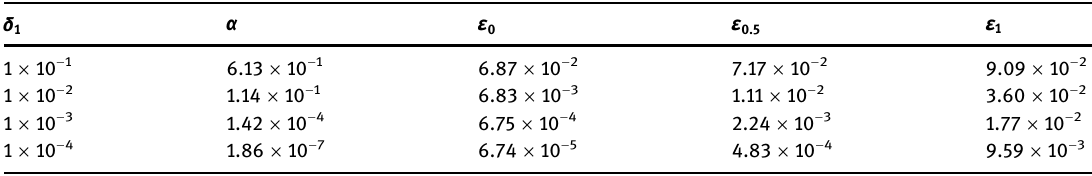
Table 2: Relative errors ε y of Example 2